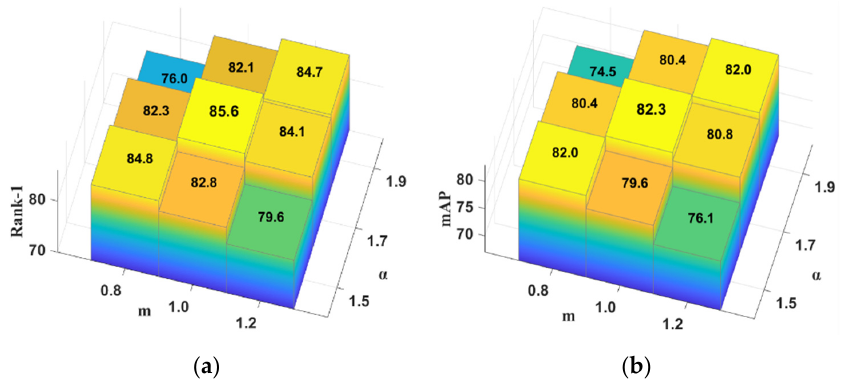
Figure 6. Optimization of AML baseline loss functions on CUHK-03 (detected) datasets. ( a ) Results of different hyperparameters on Rank-1; ( b ) Results of different hyperparameters on MAP.